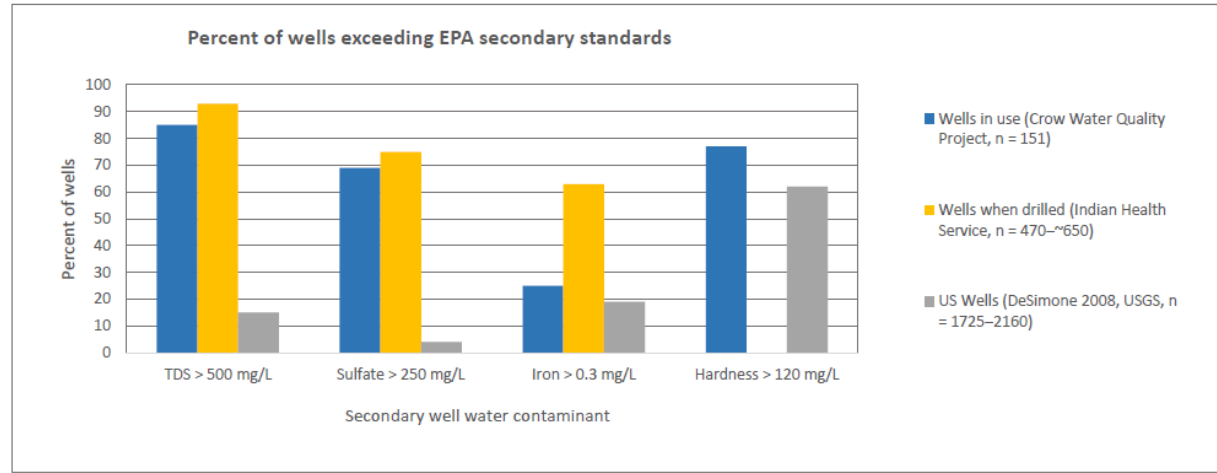
Figure 3. Percent of home wells exceeding EPA secondary drinking water standards for total dissolved solids (TDS), sulfate, iron and hardness [50], comparing Crow Tribal home wells with USGS national data [19,23]. Secondary Drinking Water Regulations provide “non-enforceable Federal guidelines regarding cosmetic effects (such as tooth or skin discoloration) or aesthetic effects (such as taste, odor, or color) of drinking water” [50]. Water exceeding 120 mg/L CaCO 3 is considered “hard,” resulting in deposits in pipes and hot water heaters and scaling on fixtures, deteriorating plumbing. The Indian Health Service did not test for hardness.